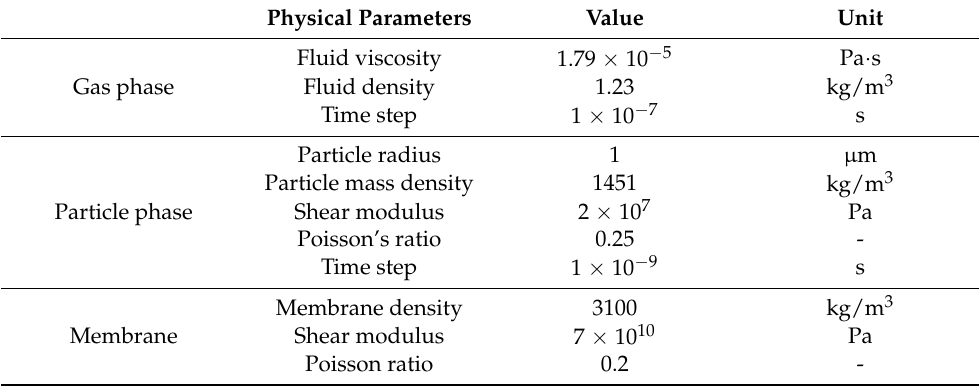
Table 1. Physical parameters.